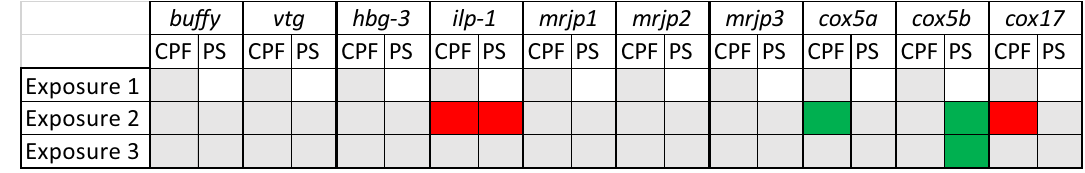
Table 1. Summary of all transcription data, red: significantly reduced expression, green: significantly increased expression and grey: no change in expression compared to control bees and white: not